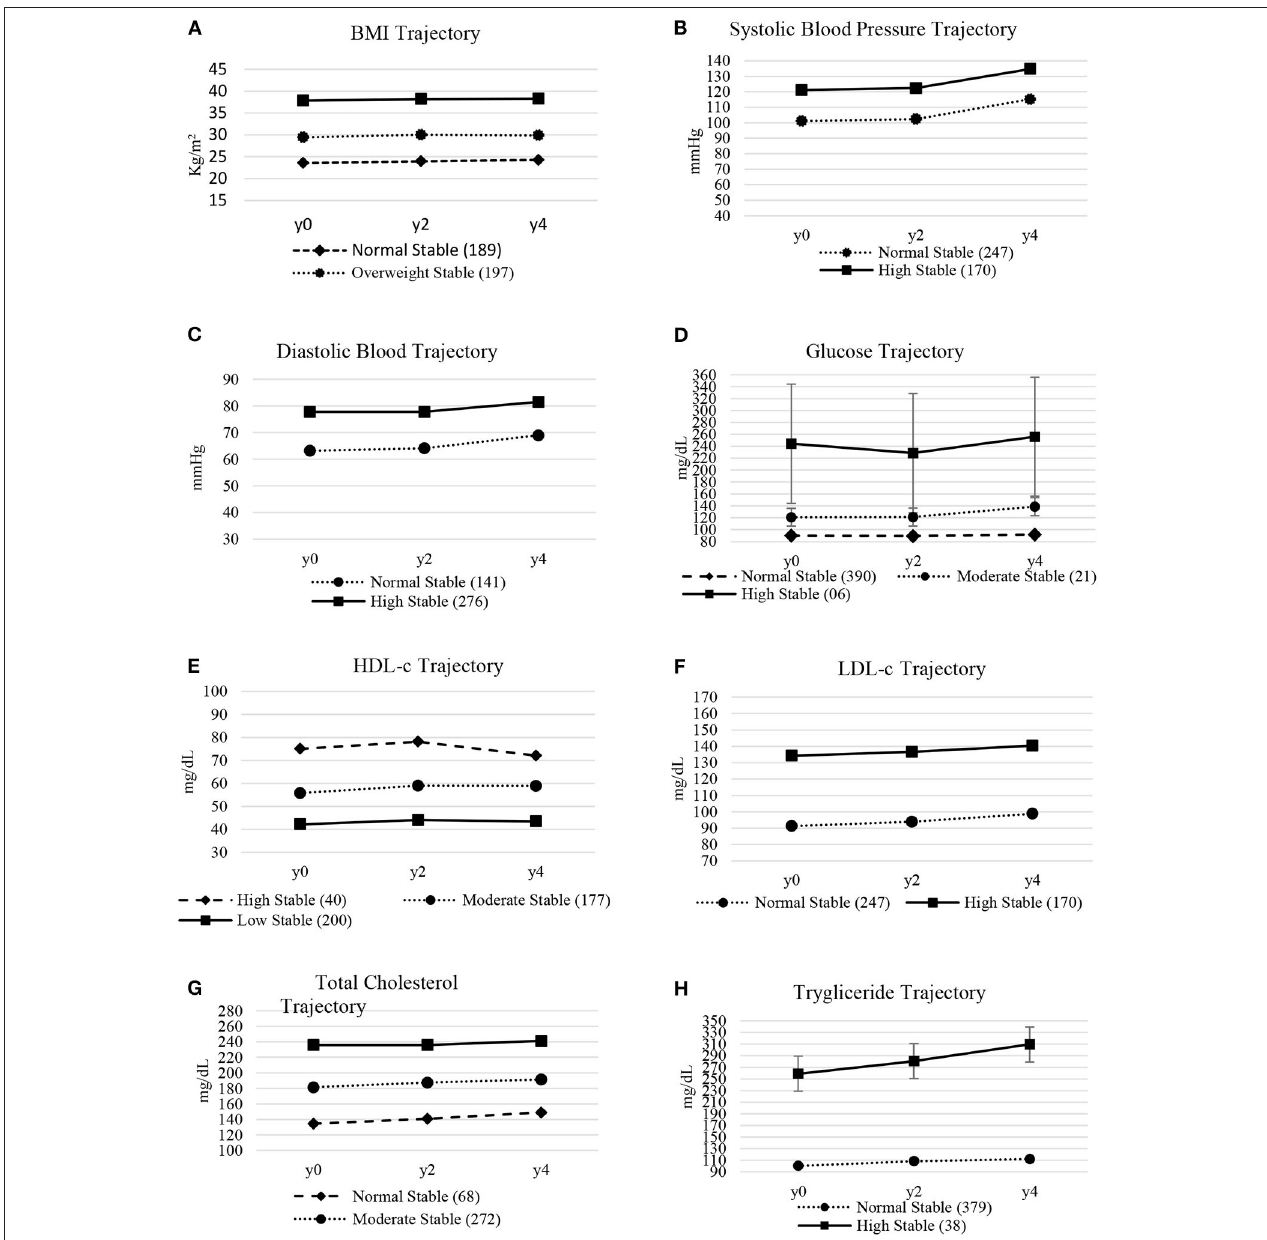
FIGURE 2 | (A–H) Average and Confidence Interval (95% CI) of the trajectory of cardiovascular risk factors of workers in a public hospital.